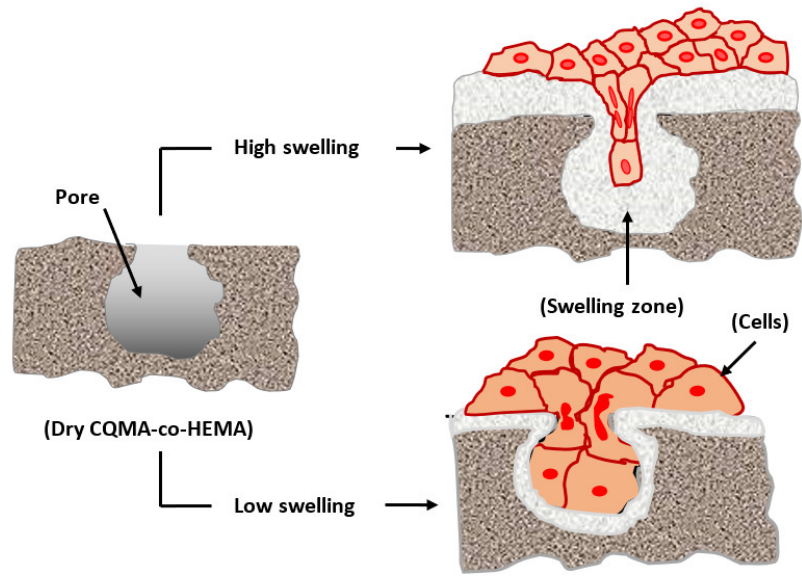
Figure 14. The effect of HCQ content in the CQMA-co-HEMA drug carrier system on Ca9-22 cell